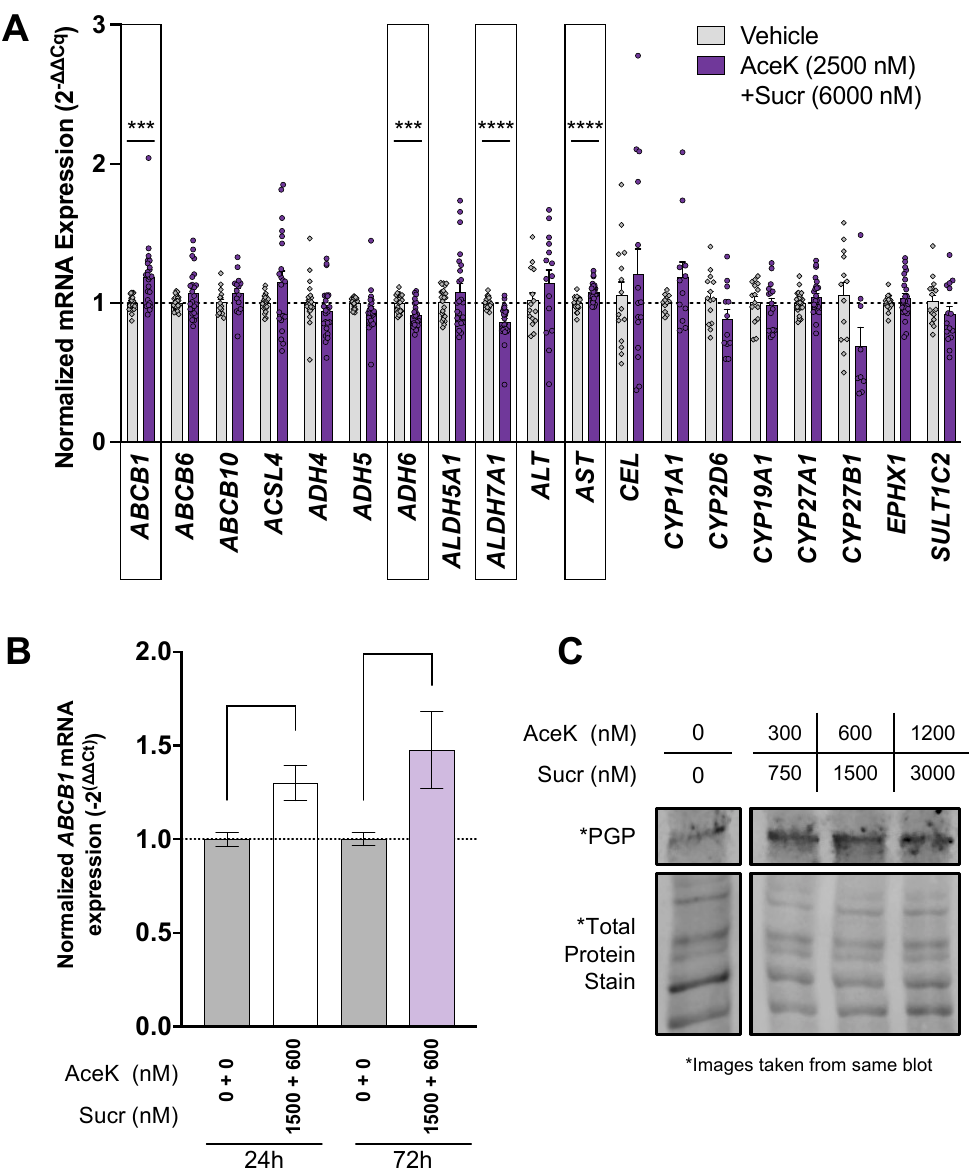
Figure 1. Acesulfame potassium (AceK) and sucralose (Sucr) alter expression of liver enzymes and P-glycoprotein. ( A ) HepG2 liver carcinoma cells were treated with a mixture of AceK and Sucr at a concentration equal to plasma concentrations after consumption of the acceptable daily intake (ADI) for each sweetener (AceK 2500 nM + Sucr 6000 nM). Expression of liver detoxification mRNA transcripts was measured by RT-qPCR and normalized against beta-actin ( ACTB ). Significance was assessed by multiple unpaired t-tests. ( B ) HepG2 were treated with AceK and Sucr at concentrations found in human plasma after consumption of an NNS-containing diet beverage (AceK 600 nM + Sucr 1500 nM) for either 24 h or 72 h. ABCB1/PGP expression was measured by RT-qPCR and normalized against beta-actin ( ACTB ). Significance was assessed by ordinary one-way ANOVA. ( C ) HepG2 were treated with a range of concentrations of combined AceK + Sucr for 72 h. PGP expression was measured by Western blot and normalized by Total Protein Stain (Invitrogen). * p < 0.05; *** p < 0.001; **** p <